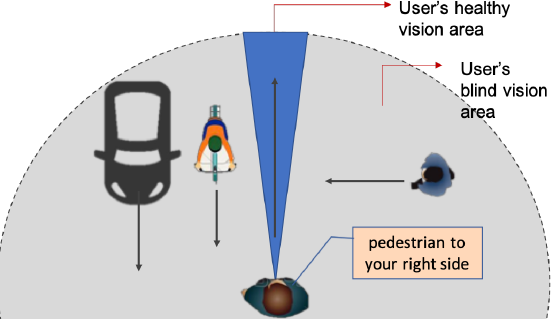
Figure 3. The conceptual representation of our